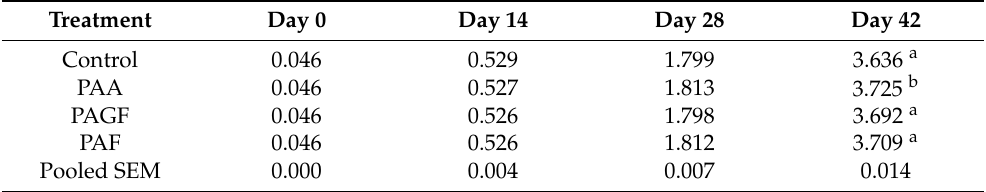
Table 1. Average live bird weights (kg) of broilers fed either a control diet or control diet with 5 mg/bird/day of phosphatidic acid added from d0–42 (PAA), d15–42 (PAGF), d29–42 (PAF).